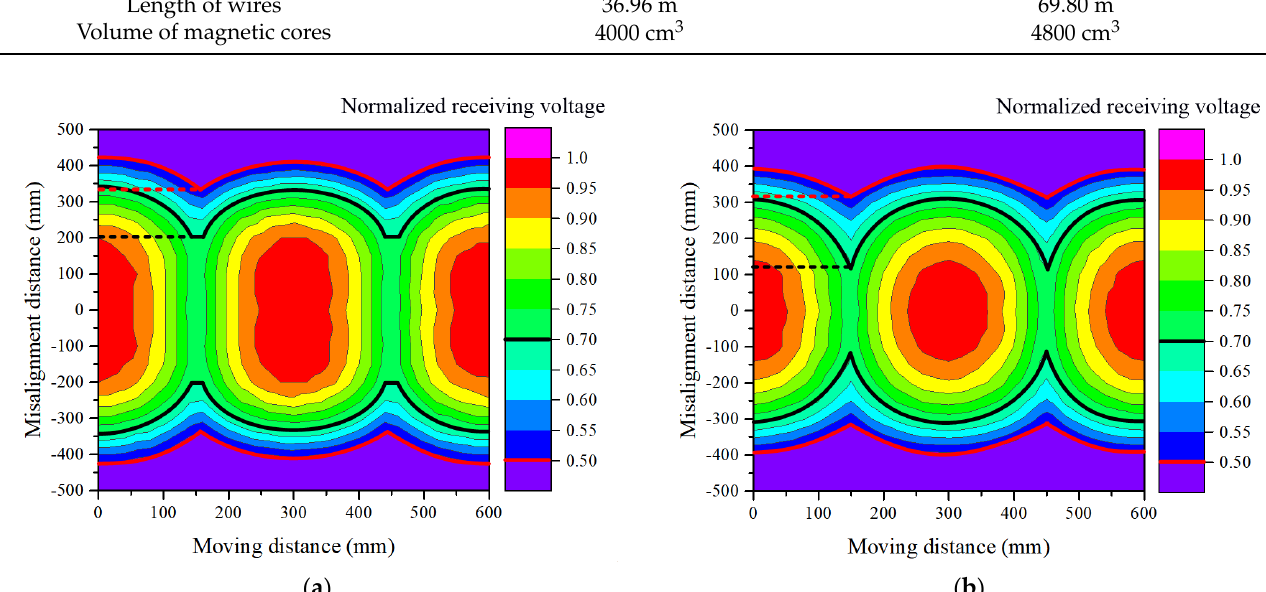
Figure 9. Simulated normalized receiving voltage of ( a ) the proposed dual-phase NSP receiver and ( b ) the reference dual-phase DD-OQO receiver with moving distance and misalignment distance.